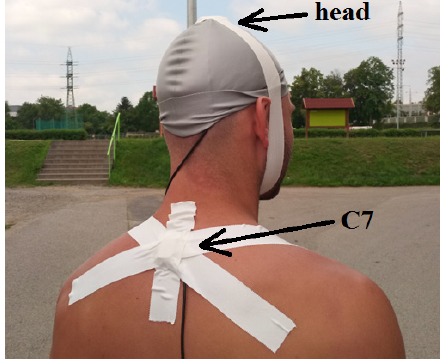
Figure 4. Acceleration sensor placed on the test subject’s head and C7 vertebrae.